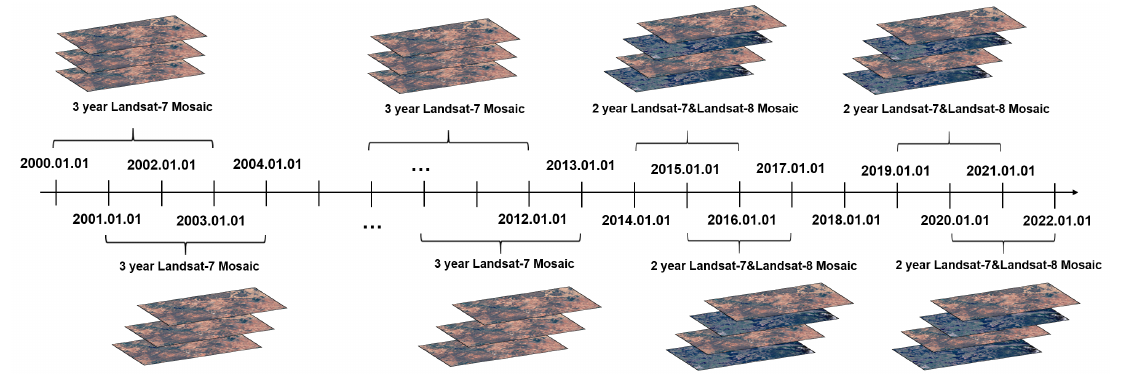
Figure 3. The rolling method was used to generate a multi-temporal NDVI composite time series from 2000 to